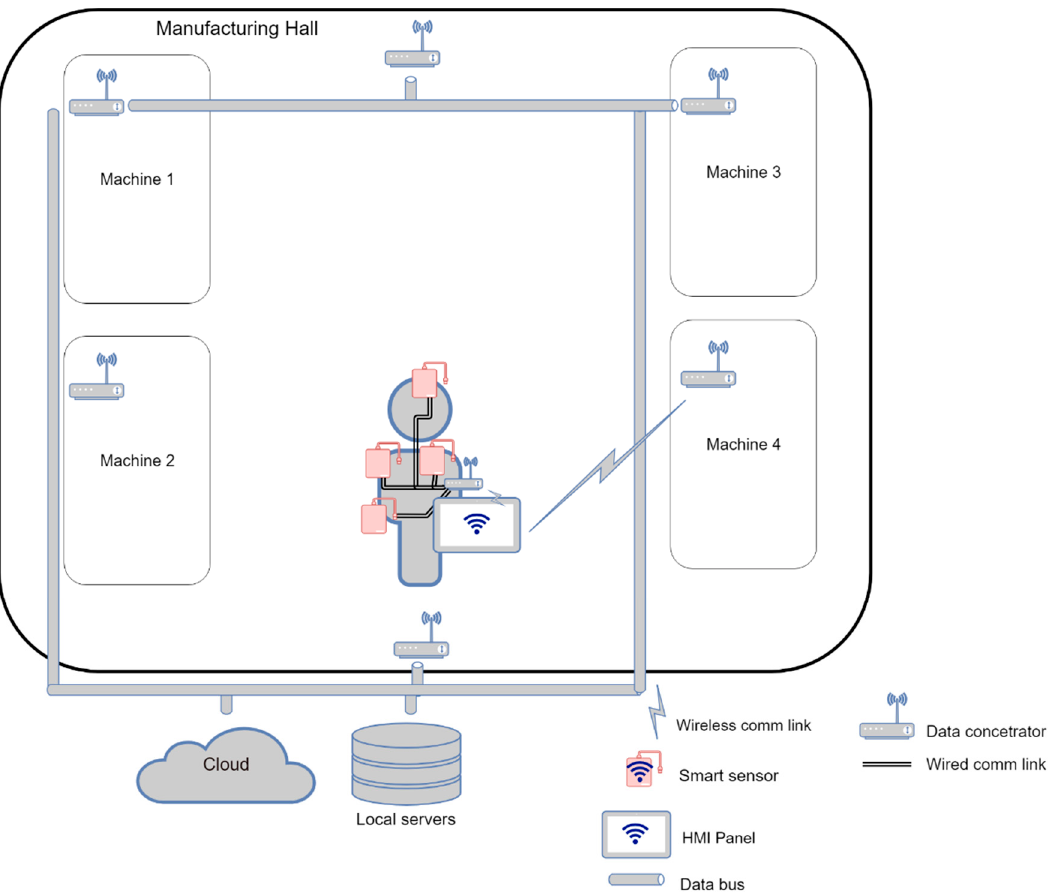
Figure 8. Use case III : Wired interconnection in the SmartJacket.